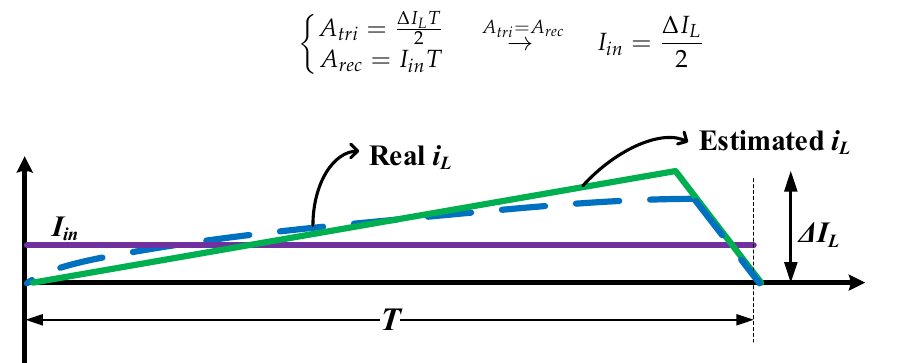
Figure 5. Estimation of I L based on the average value of the input current.